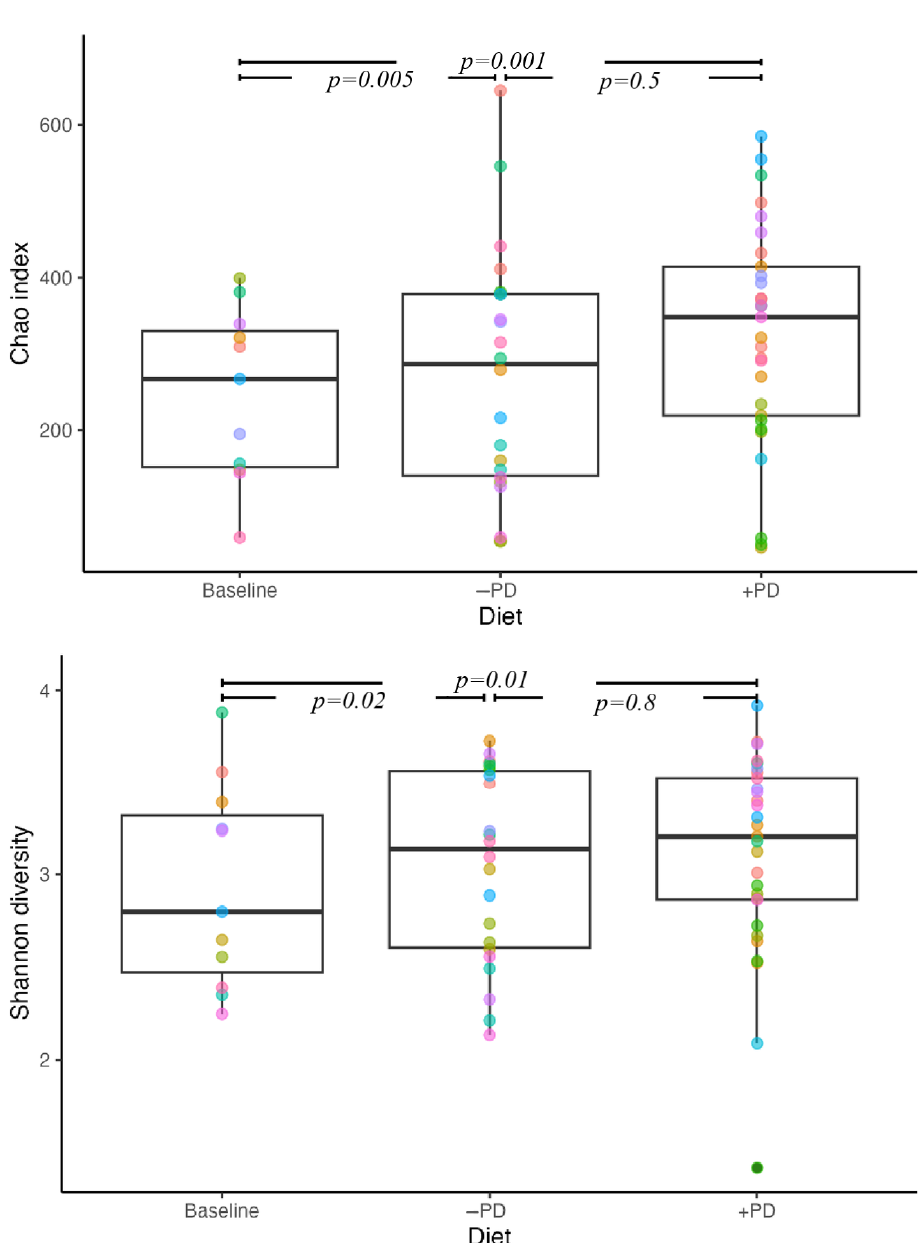
Figure 5. Faecal microbiome alpha diversity in privately owned healthy adult dogs (n = 11) fed a commercial diet with (+PD) or without ( − PD) Enterococcus faecium NCIMB 10415 10 9 CFU/kg for 16 days each, in a crossover study design. Boxplots showing the observed richness (Observed ASV), Chao1 and Shannon index, of the faecal microbiome when the study population was fed a diet manufactured with (+PD) or without ( − PD) Enterococcus faecium NCIMB 10415 as compared to baseline diversity at inclusion. Each number on the plot identifies the individual dog across diets. For the beta diversity, no separation of faecal microbial communities was detected relating to the diet or diet order using Bray–Curtis (R 2 = 0.014, p = 0.3 and R 2 = 0.04, p = 0.1, respectively), unweighted UniFrac (R 2 = 0.02, p = 0.2 and R 2 = 0.03, p = 0.1, respectively) or weighted UniFrac (R 2 = 0.002, p = 0.4 and R 2 = 0.002, p = 0.4, respectively). For details on beta diversity, please refer to Figure